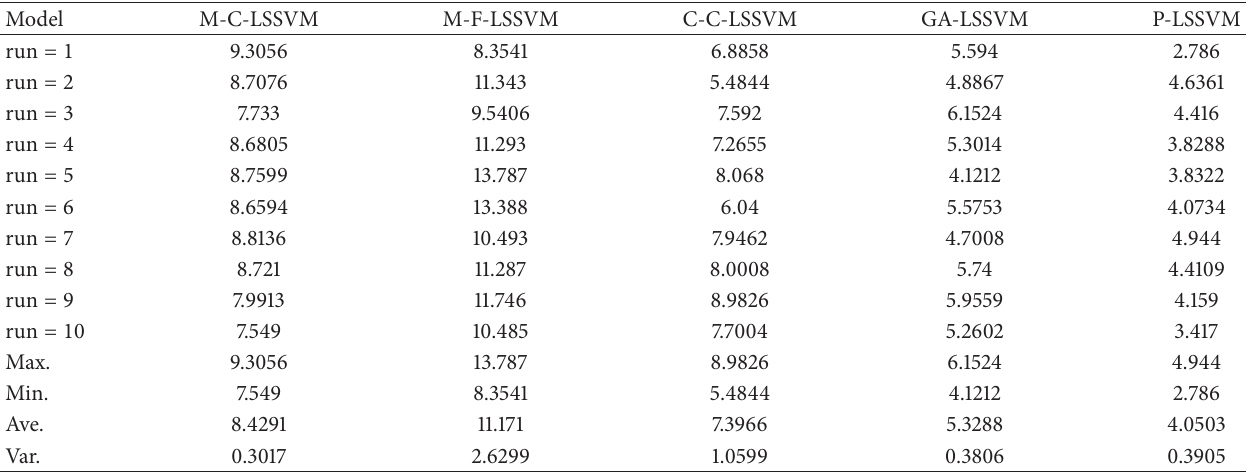
Table 10: Five models predicted error based on NMSE for FM broadcasting band.